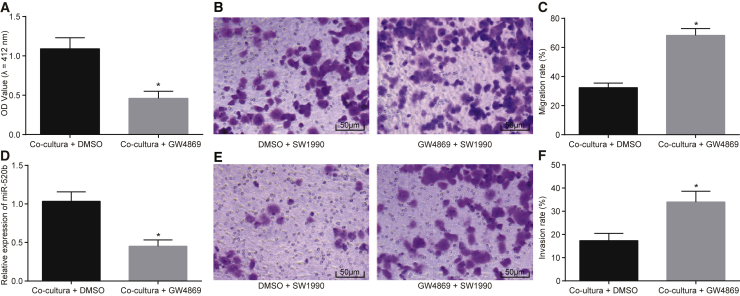
The Migration and Invasion of PC Cells Are Promoted by Suppressing the Release of Exosomes(A) The release of exosomes after GW4869 treatment in the coculture system of SW1990 cells and NFs by acetylcholinesterase activity detection. (B) Representative images of migration ability of SW1990 cells cocultured with NFs after GW4869 treatment assessed by the Transwell assay (×200). (C) The migration rate of SW1990 cells cocultured with NFs after GW4869 treatment assessed by the Transwell assay. (D) miR-520b expression after GW4869 treatment in SW1990 cells cocultured with NFs determined by qRT-PCR. (E) Representative images of the invasion ability of SW1990 cells cocultured with NFs after GW4869 treatment detected by the Transwell assay (×200). (F) The invasion rates of SW1990 cells cocultured with NFs after GW4869 treatment detected by the Transwell assay. PC, pancreatic cancer. *p < 0.05 versus the coculture + DMSO group. Data in the figure were measurement data, which were presented as mean ± standard deviation, and the difference of which between two groups was compared by independent-sample t test. The experiment was repeated 3 times independently.